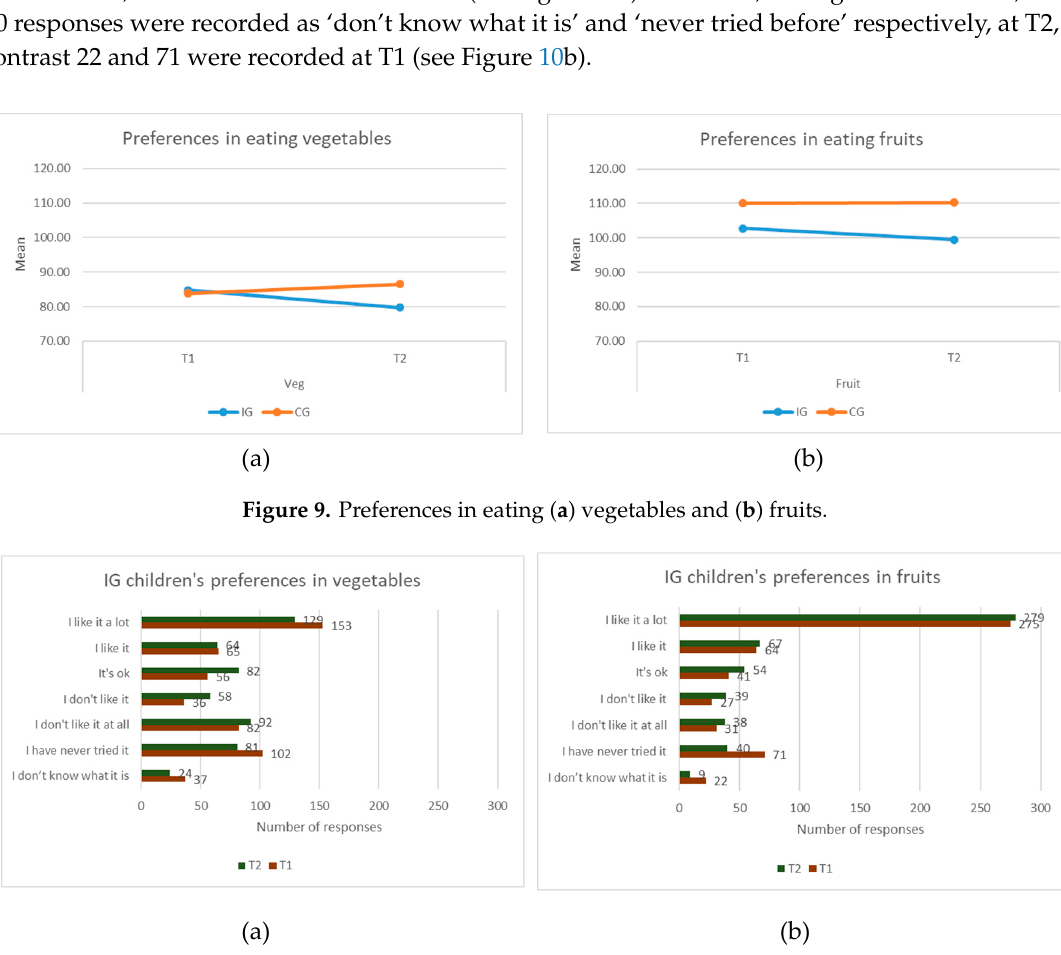
Figure 10. Intervention Group (IG) children’s preferences for (a) vegetables (b) fruits, before and after intervention.